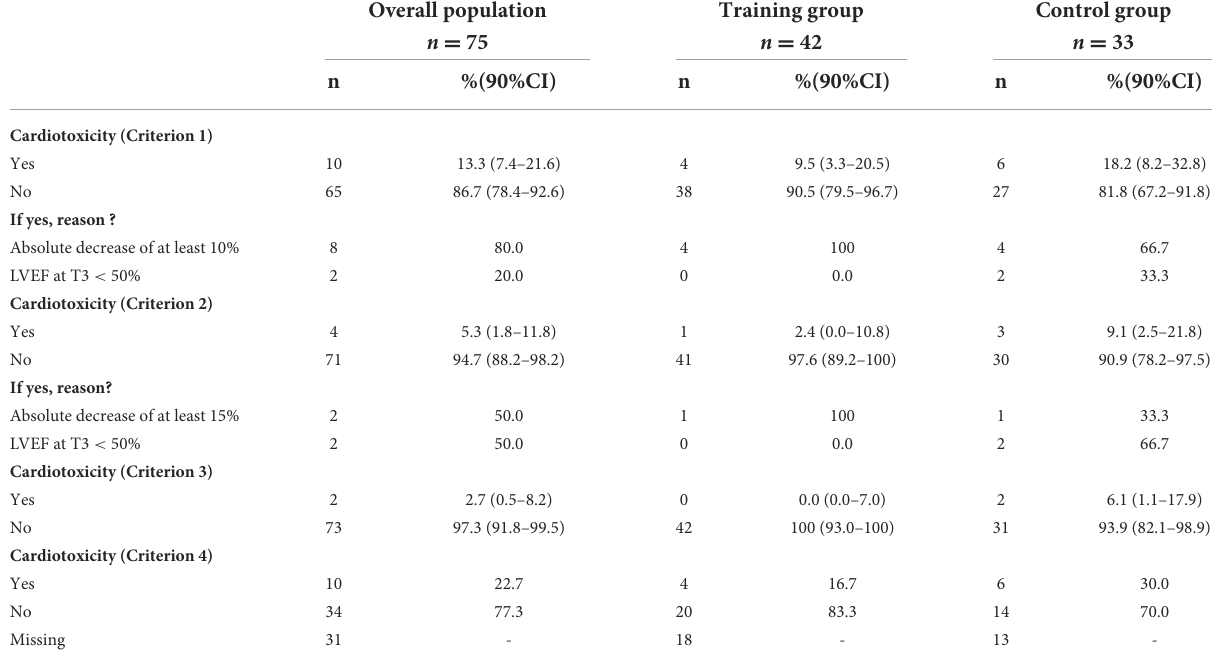
TABLE 3 Study of cardiotoxicity at T3 according to the different criteria, in patients of both groups (TG and CG). Overall population Training